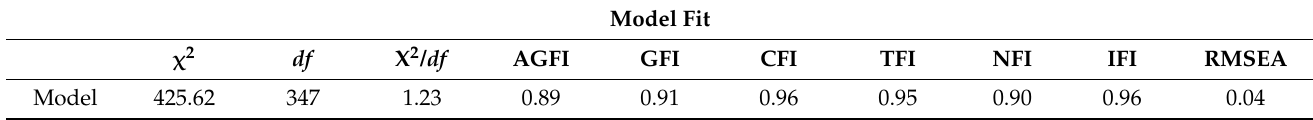
Table 11. Model Table 11. Model Fit.